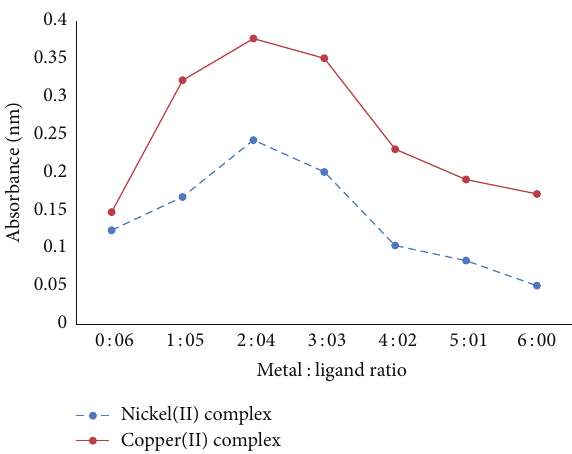
Figure 4: Job’s curves of equimolar solutions at 622 nm copper ion and 640nm nickel ion